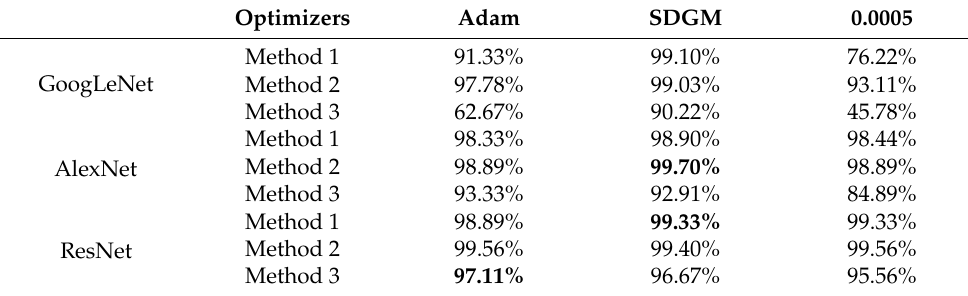
Table 7. Model accuracy using different